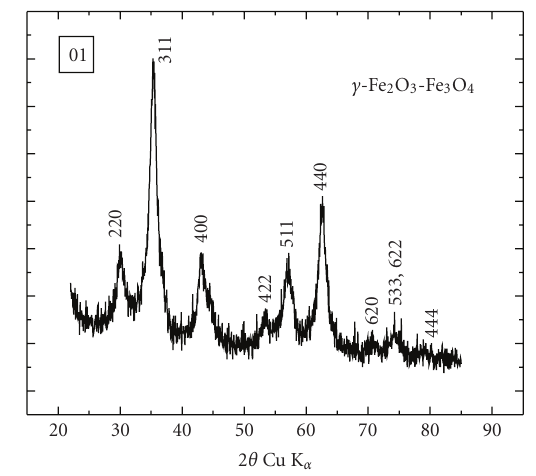
Figure 2: XRD di ff raction patterns for a laser-synthesized iron oxide (sample 01): peak identification points to a chemical com- position containing maghemite/magnetite iron oxide